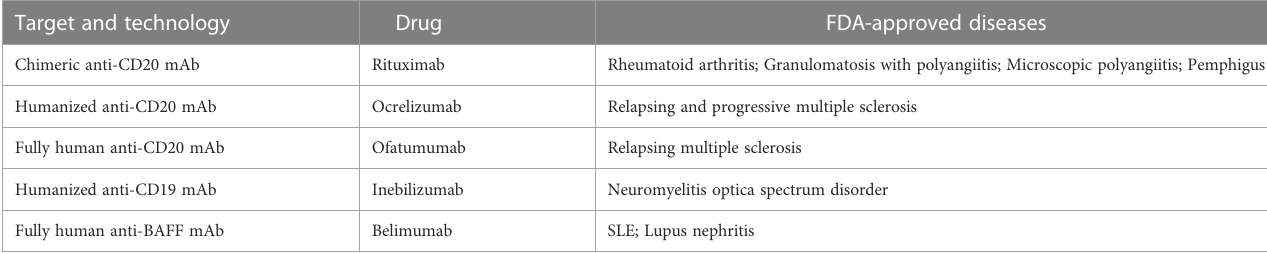
TABLE 1 FDA approved mAbs in autoimmune